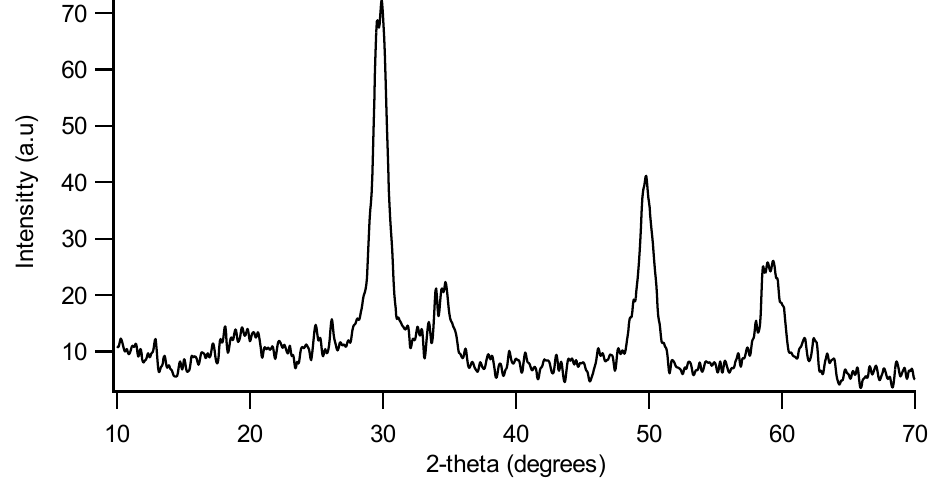
Figure 4. XRD pattern of Ce that deposited on cordierite substrate.